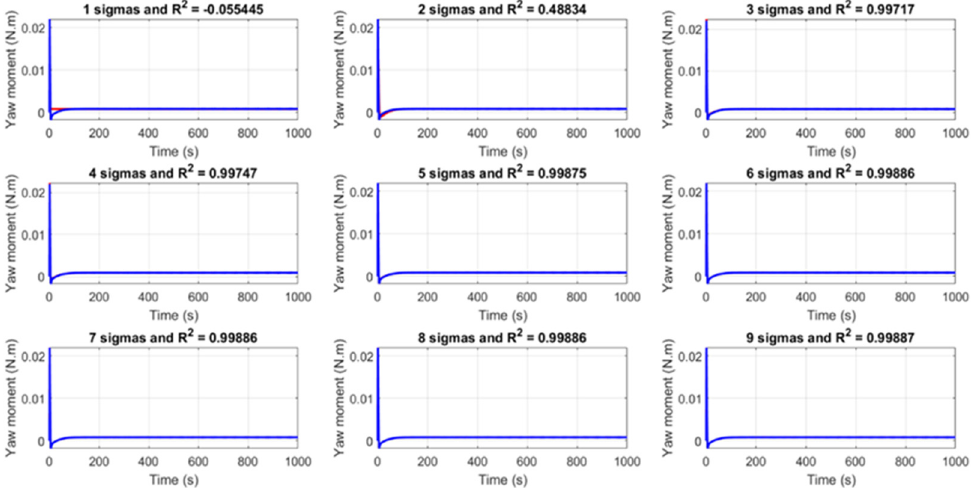
Figure 5. Measured (blue curves) vs. estimated yaw moment (red curves) for 25° turning manoeuvre. Table 3. Sway adjustment coefficients and uncertainties for simulation of 25° turning manoeuvre.